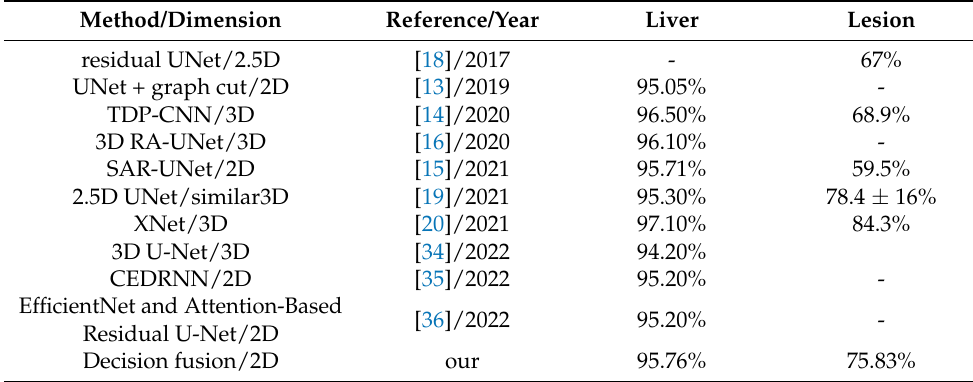
Table 3. Performance comparison between the proposed system and other